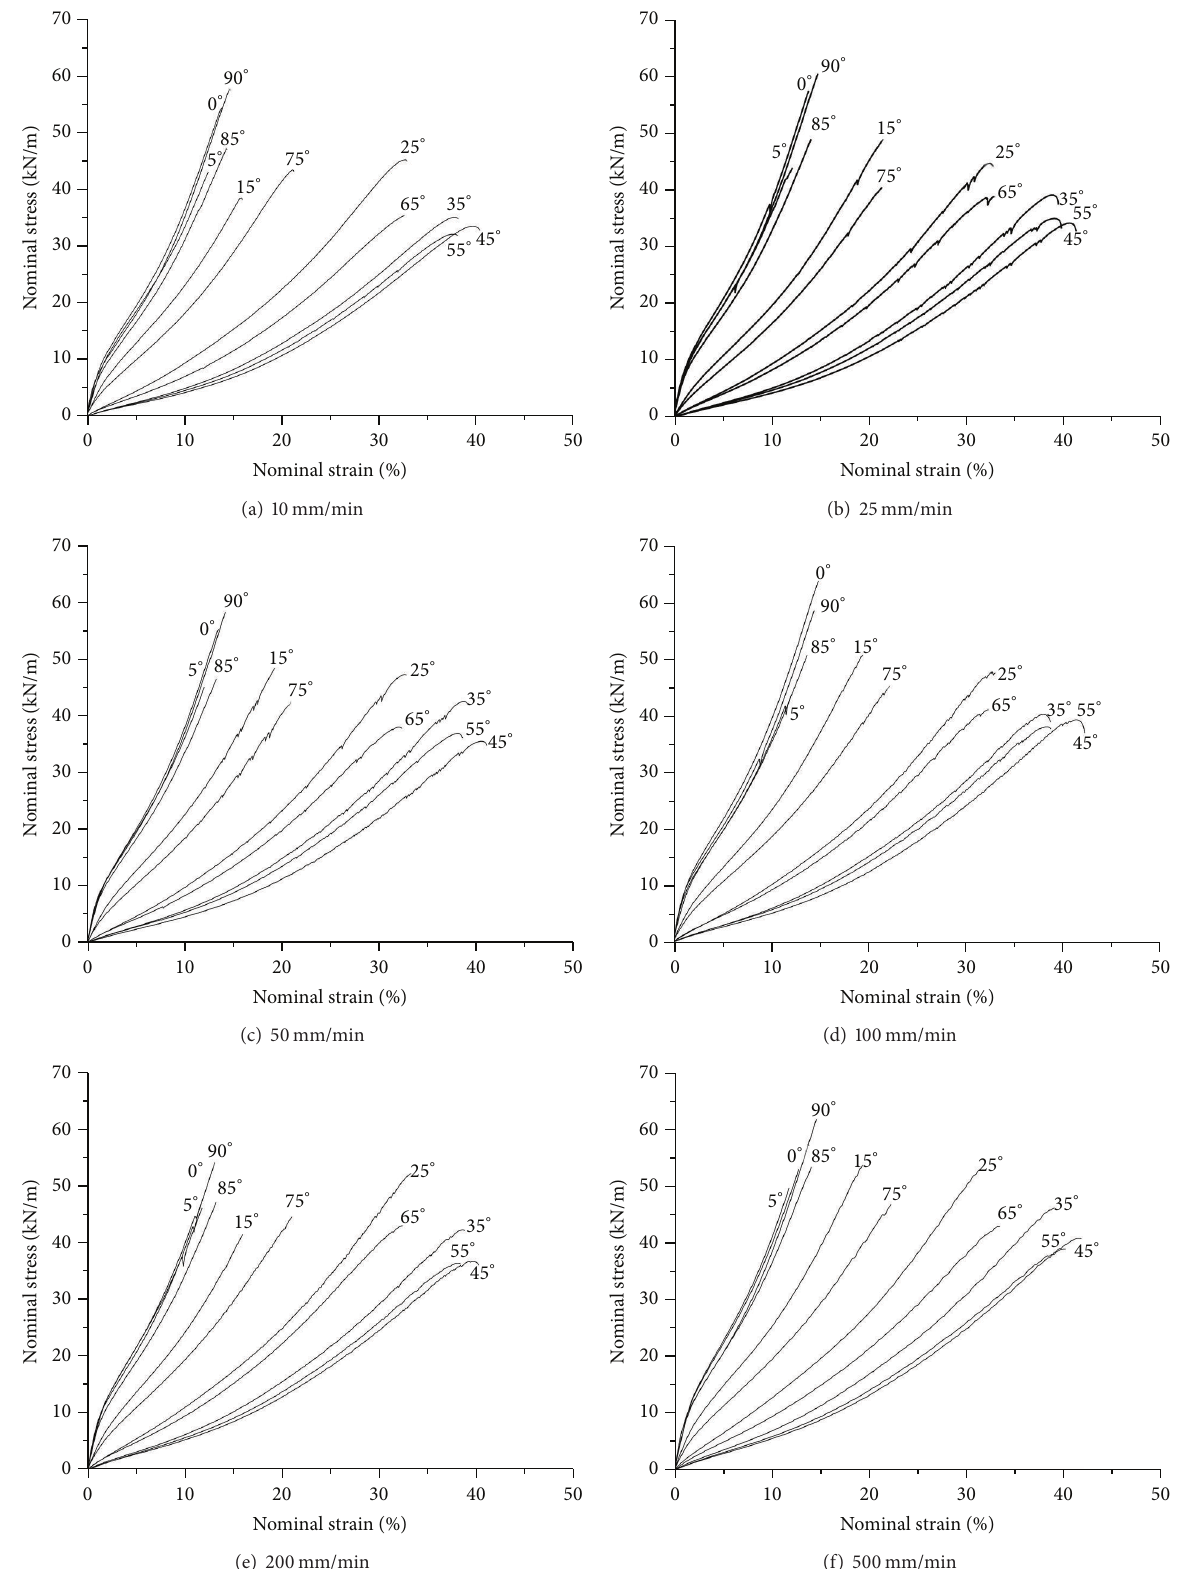
Figure 3: Off-axial tensile curves of Precontraint 702 T2 under different loading